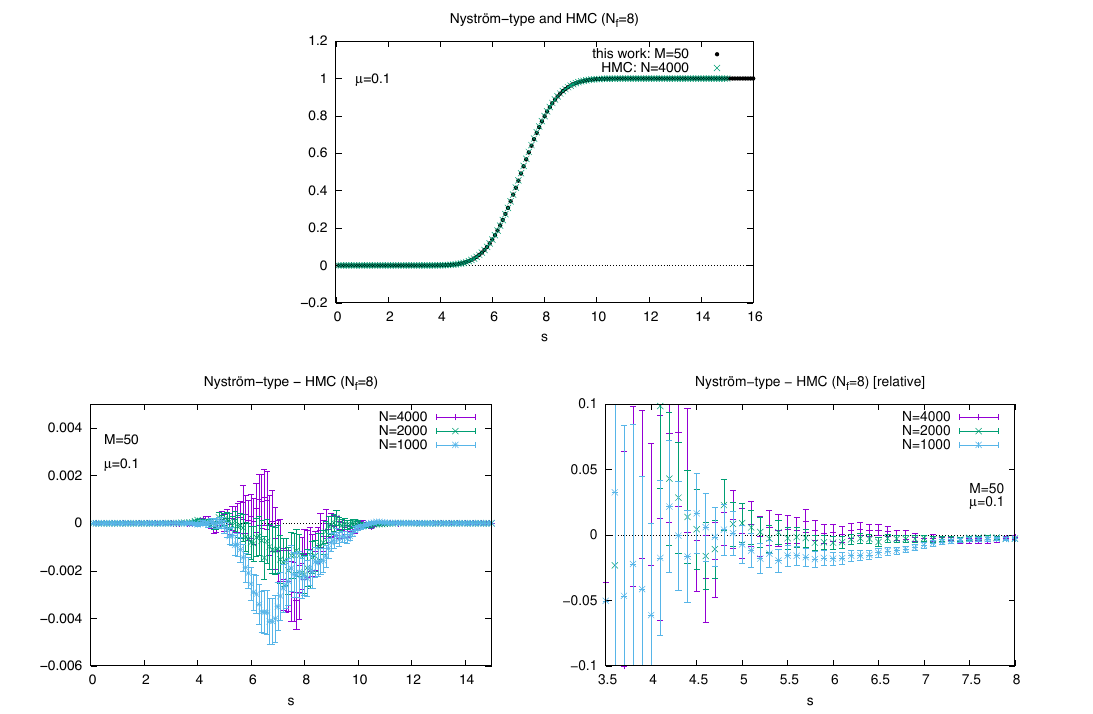
Figure 7 . The same plot as (cid:12)gure 3 but with N F = 8. F 1 ( s ) is computed in two ways for the chiral GSE with N F = 8 doubly-degenerated masses in the complete con(cid:13)uent limit with (cid:22) 1 = 0 : 1 and the topological charge (cid:23) = 0. Nystr(cid:127)om-type discretization of order M = 50 (black dot) and hybrid Monte Carlo simulation with the random rank N = 4000 are applied (green cross) in the top panel, and the random rank N = 4000 (green dots in the top (cid:12)gure), respectively. The errors for HMC is smaller than the symbols and not shown in the plot. The bottom panels show the di(cid:11)erence F 1 ( s ) (cid:0) F HMC ( s ) for N = 1000 ; 2000 ; 4000. As the N grows, the HMC results converge 1 to the result from Nystr(cid:127)om-type discretization. Compared with the previous cases, however, its convergence is